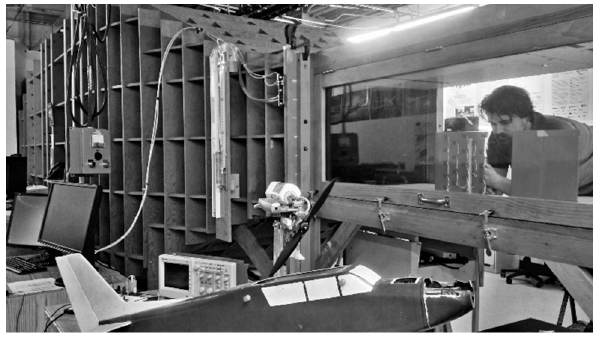
Figure 12. Price–Païdoussis subsonic wind tunnel of LARCASE.